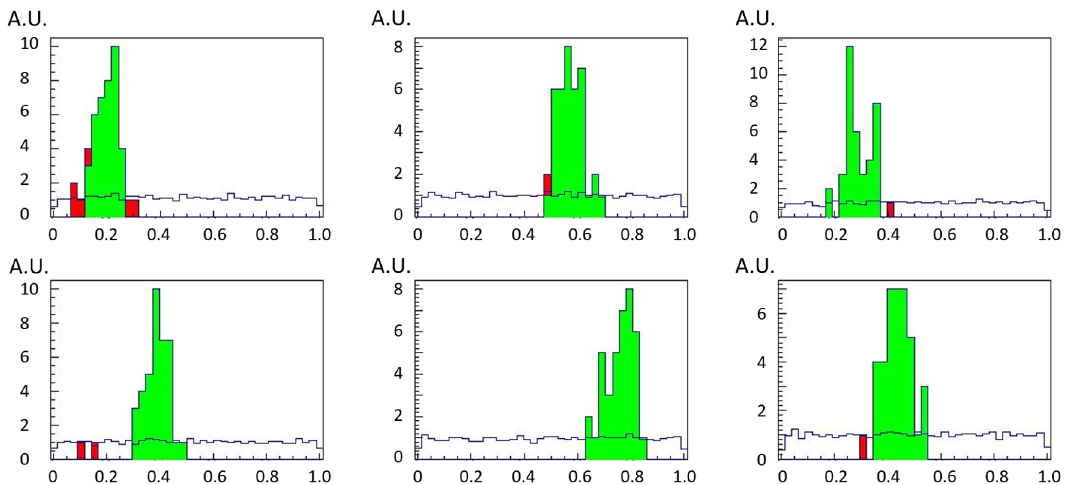
Figure 9 . Copula space distributions of the six features defining the subspace, among 1000 randomly chosen six-dimensional ones, where RanBox finds the highest- Z box in a run on 5000 synthetic PL events, 4950 of them generated from a D = 20 -dimensional uniform distribution and the remaining 50 “signal” events generated with 11 features drawn from a multidimensional Gaussian distribution. The blue histograms show the totality of the data; the filled green histograms show the distribution of events contained in the highest- Z box; the filled red histograms show the distribution of events PL that fail to be contained in the box only because of their value on the displayed variable. See the text for more